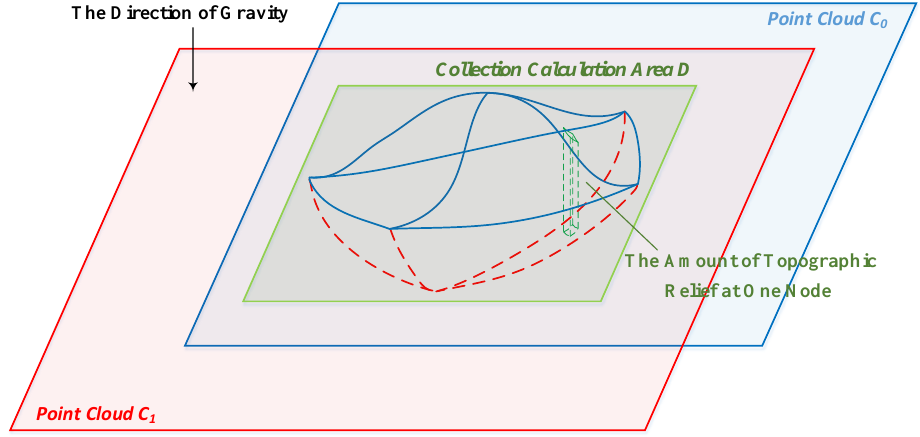
Figure 8. Soil collection calculation based on the cumulative relief.